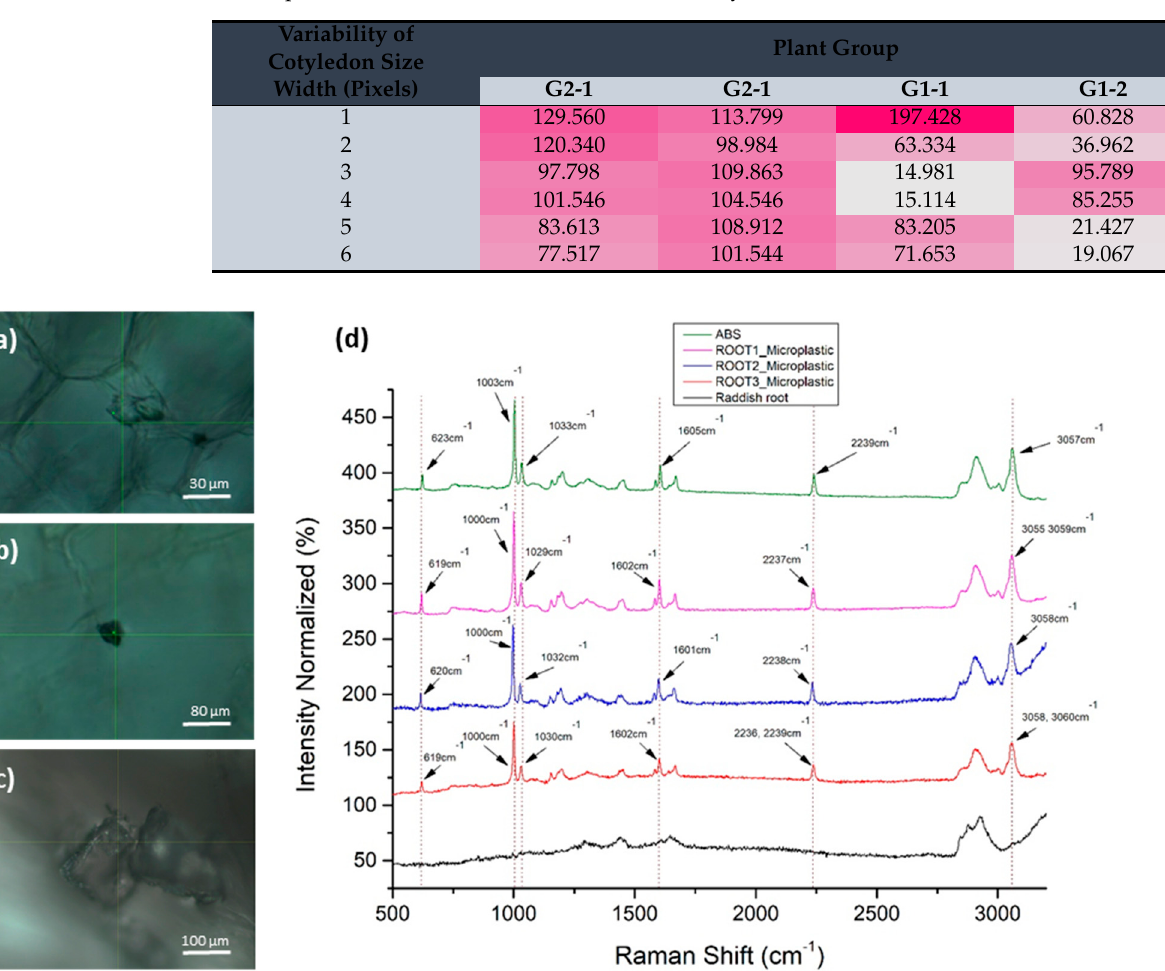
Table 1. Cotyledon width variability within the groups (G) of radish seedlings, in the two experi- mental setups (E). Cotyledon width values are linearly correlated with the color saturation of the heatmap to enhance visualization of width variability.